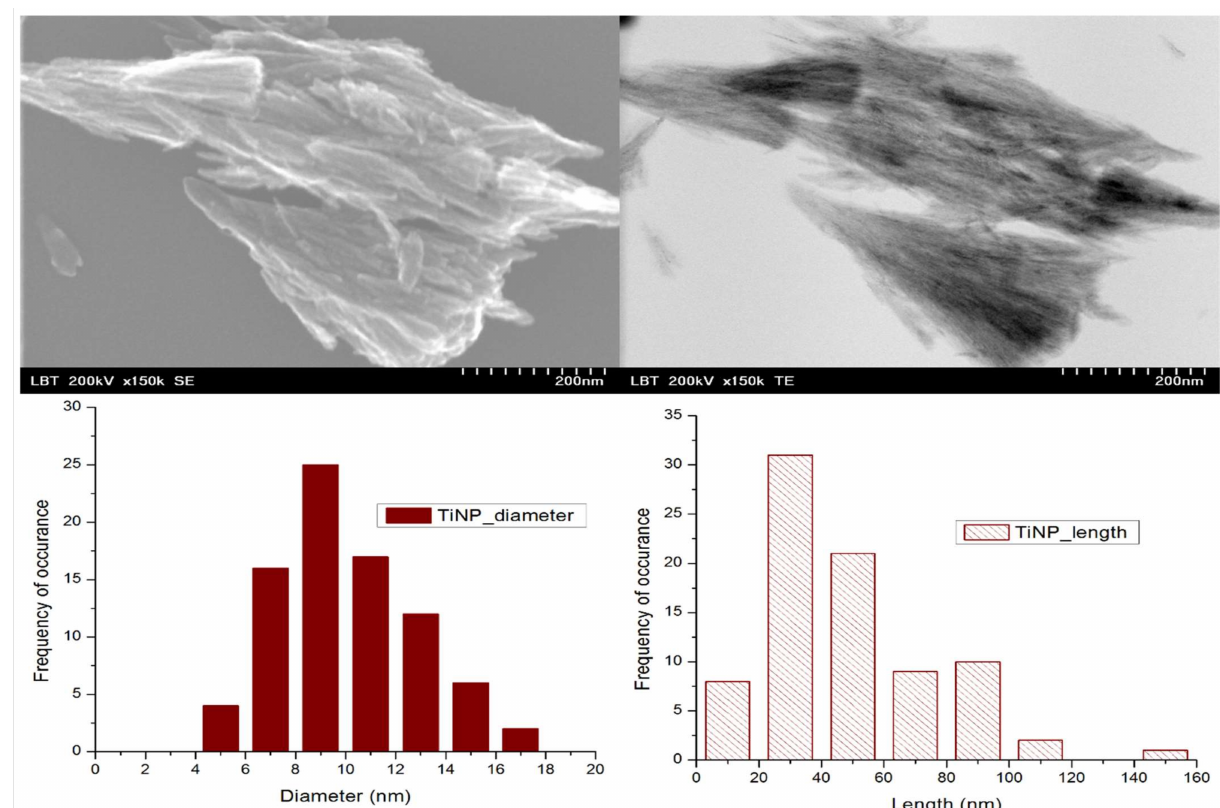
Figure 2. STEM micrographs of the TiO 2 nanostructures and the diameter and length distributions.